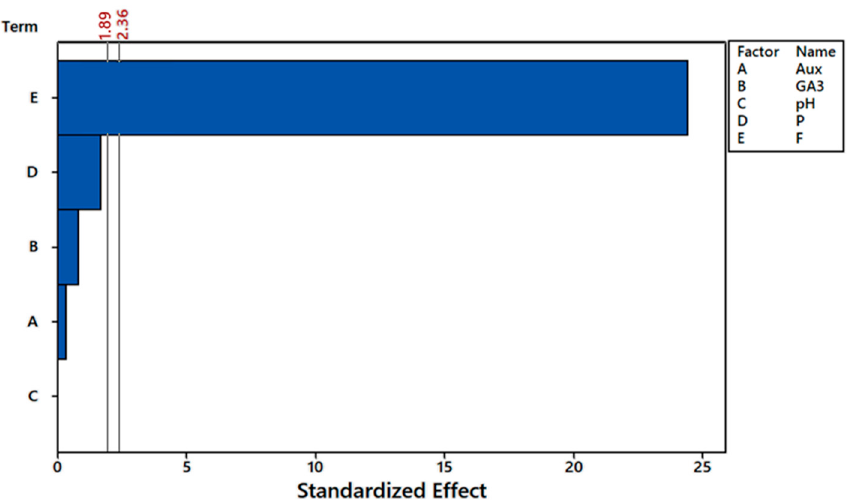
Figure 2. Pareto chart of first order effects for auxin (A), gibberellin (B), pH (C), phosphorus initial concentration (D), and fluoride initial concentration (E) on removed mass of fluoride, considering α = 10% (1.89) and α = 5% (2.36). The bars behind the thresholds of α values represent factors that were not significant to the response variable.